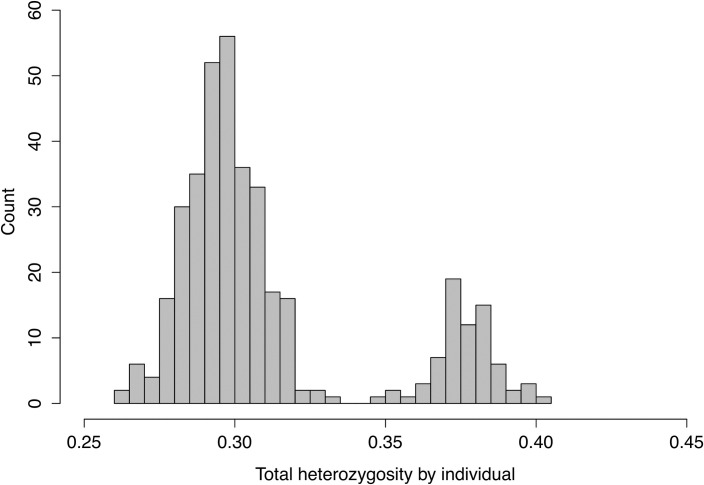
Bar plot of heterozygosity by individual among 15,802 SNPs generated by GBS.The first cluster (heterozygosity ≤ 0.335) contains all diploid accessions whereas the other cluster (heterozygosity ≥ 0.345) comprises triploid accessions according flow cytometry analysis.